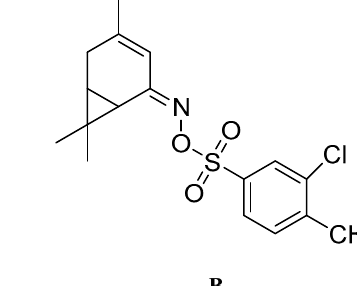
A B Figure 3. The proposed new molecules based on the established CoMFA model: ( A ) ( Z )-3-Caren-5-one O -(3-nitro-4-methylbenzenesulfonyl) oxime; ( B ) ( Z )-3-Caren-5-one O -(3-chloro-4-methylbenzenesulfonyl) oxime.